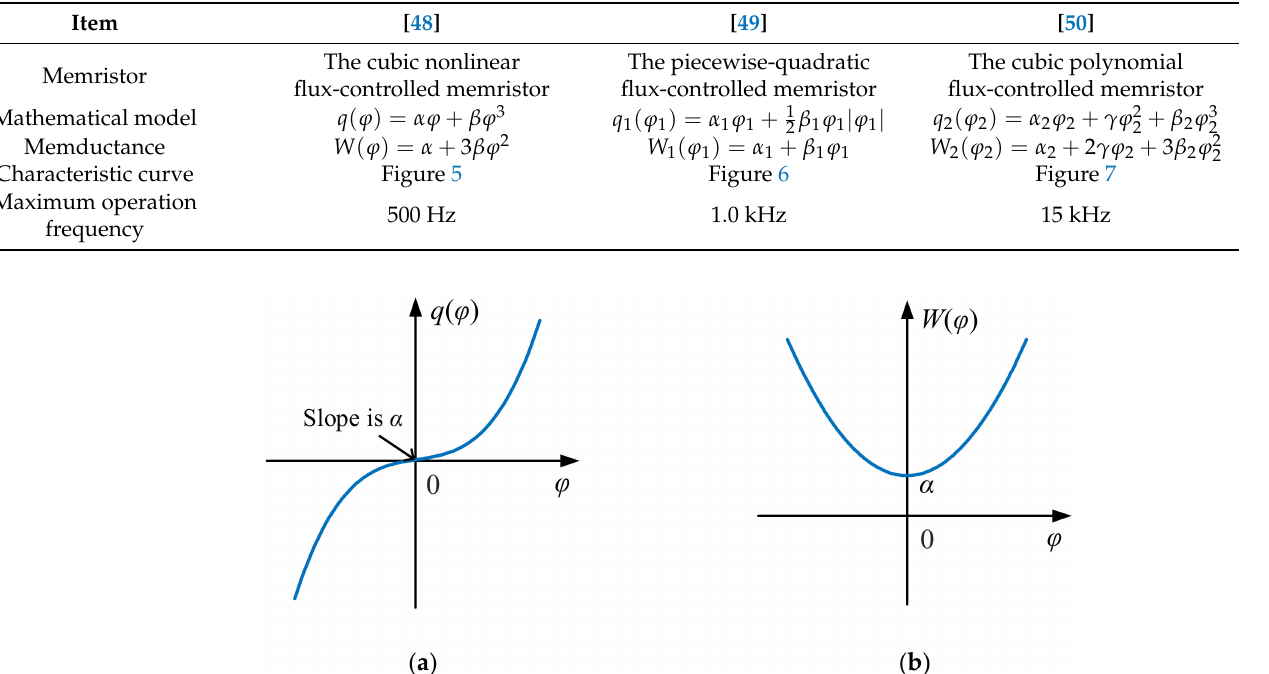
Table 4. Existing memristor emulators.